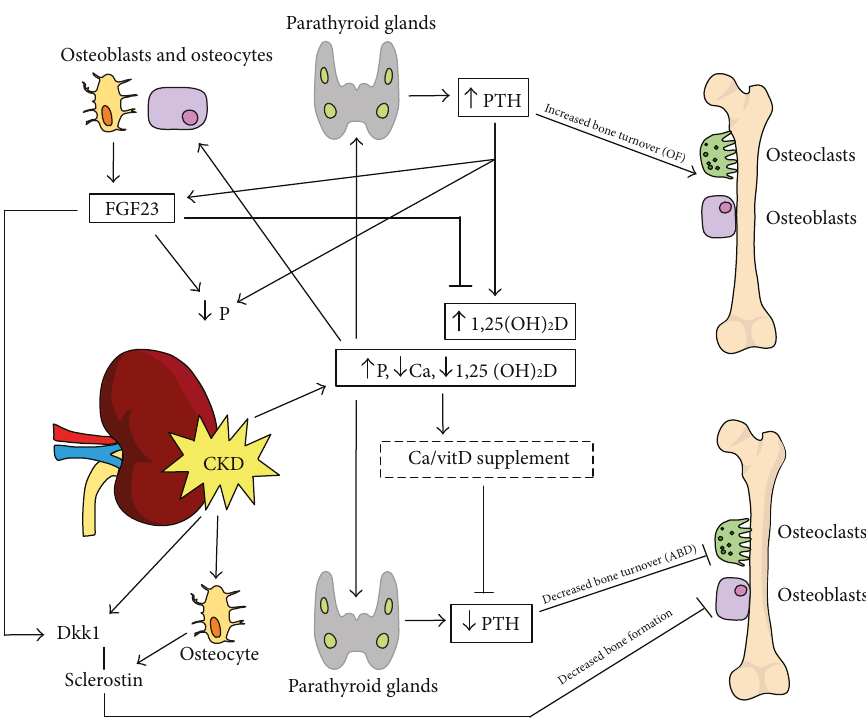
Figure 1: Mineral and bone disorders in chronic kidney disease (CKD). Elevated phosphorus (P), low calcium (Ca), and 1,25 (OH) stimulate parathyroid hormone (PTH) production by the parathyroid glands, which leads to increased bone turnover and P excretion by the kidneys. High PTH and P also seem to either directly or indirectly stimulate fi broblast growth factor 23 (FGF23) production by osteoblasts and osteocytes, though this seems at least partly mediated by an upregulation of vitD by high PTH, which in turn activates FGF23 production. While FGF23 stimulates P excretion, it further suppresses vitD production. Suppression of PTH levels may arise from Ca and vitD supplements or treatment with calcimimetics in CKD. Suppressed PTH levels will lead to decreased bone